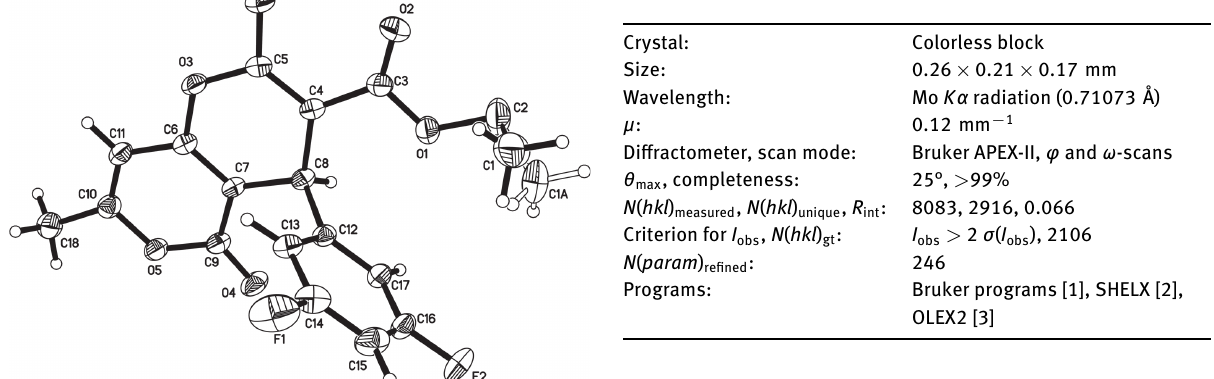
Table 1: Data collection and handling.